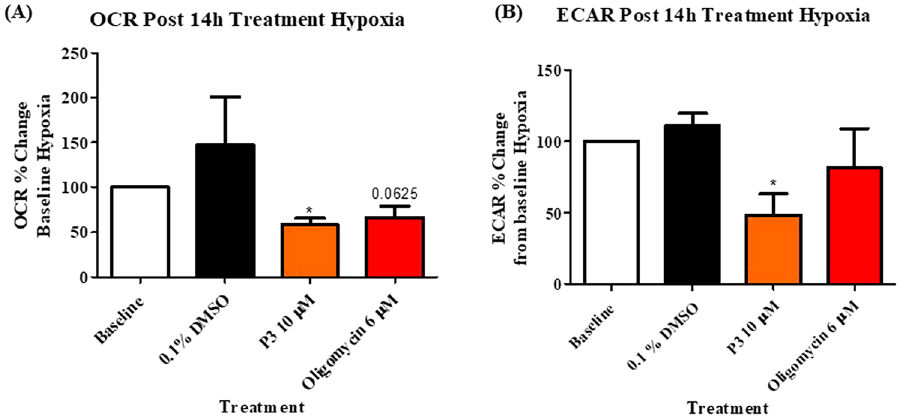
Figure 4. Pyrazinib (P3) significantly inhibits OCR and ECAR in OAC patient biopsies cultured under hypoxia (0.5% O 2 ). ( A ) Percentage change from baseline OCR metabolic rate under hypoxia (0.5% O 2 ) to OCR following treatment with 0.1% DMSO control, 10 µM Pyrazinib (P3) or 6 µM Oligomycin under 0.5% O 2 , (n = 6). ( B ) Percentage change from baseline of ECAR metabolic rate under hypoxia to ECAR following treatment with 0.1% DMSO control, 10 µM Pyrazinib (P3) or 6 µM Oligomycin under 0.5% O 2 , (n = 6). Wilcoxon signed rank t-test,* p < 0.05. Data expressed as mean +